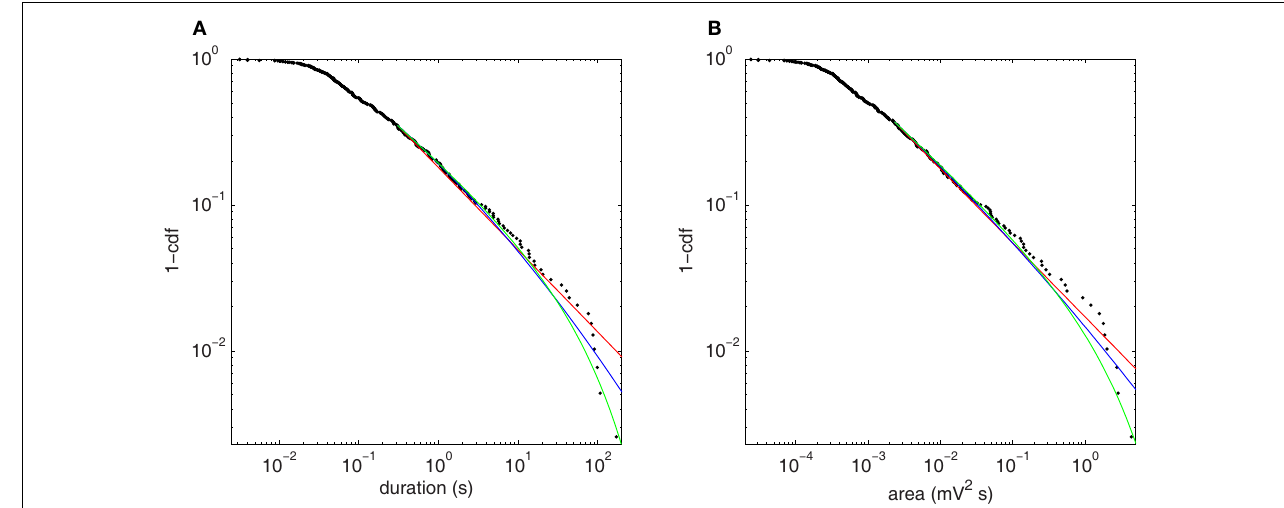
FIGURE 9 | Upper cumulative distributions of fluctuation statistics at the bifurcation point H3u, using squared Hilbert amplitude thresholded at 0.008mV 2 , with power law (red), power law with exponential cutoff